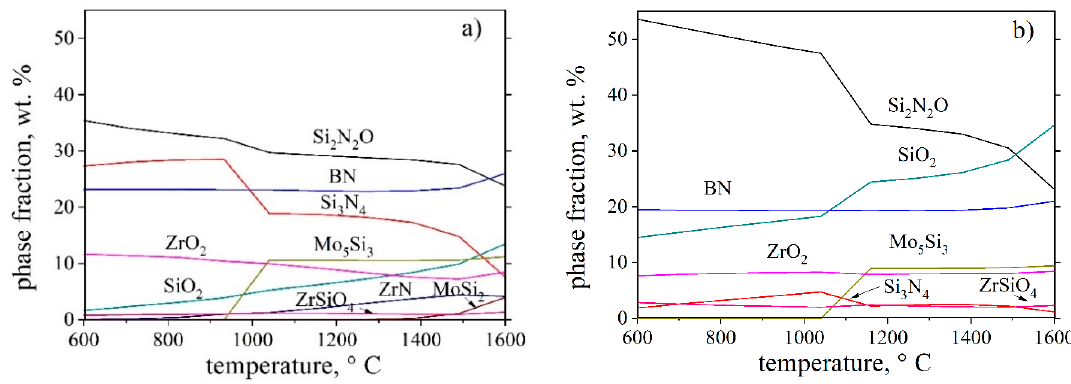
Figure 5. Calculated equilibrium phase amounts in the temperature range from 600 °C to 1600 °C of ( a ) Si-N 2 -H 2 -O 2 -Mo-Zr-B (0.238-0.596-0.193- 0.050 -0.082-0.019-0.036) mol and ( b ) Si-N 2 -H 2 -O 2 -Mo-Zr-B (0.238-0.596-0.193- 0.100 -0.082-0.019-0.036) mol.